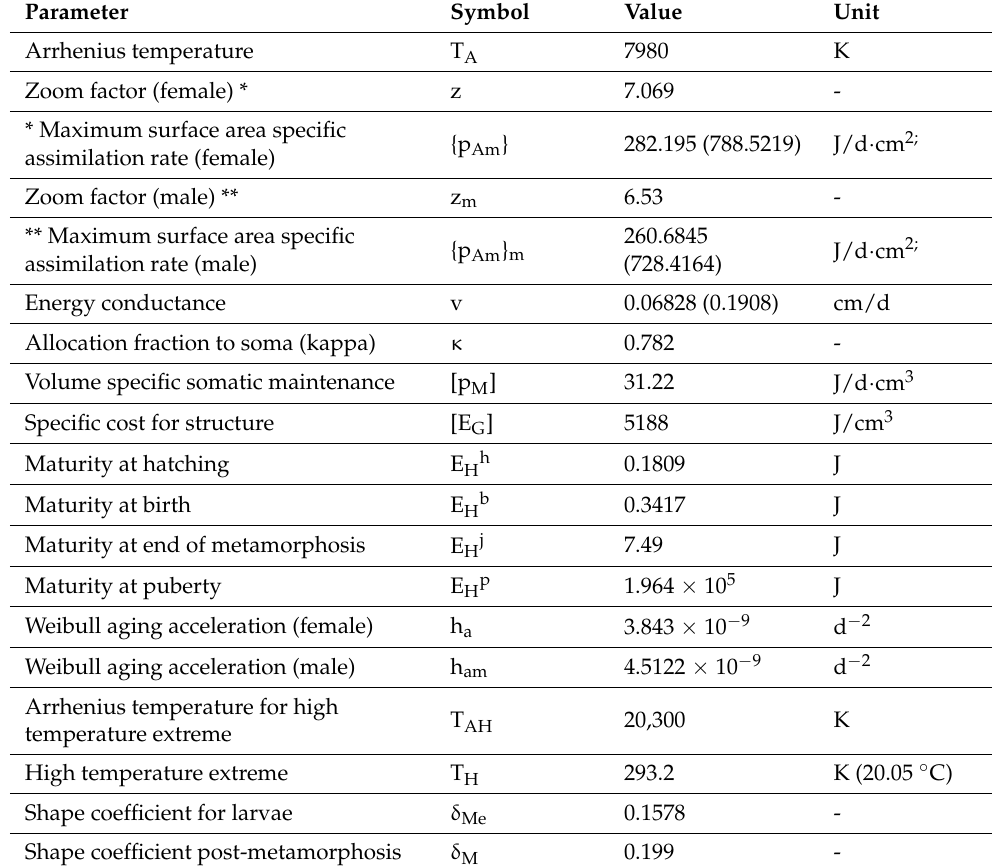
Standard parameter values from Kooijman (2010) [20]: Maximum specific searching rate, {F m } = 6.5 d − 1 · cm − 2 ; Digestion efficiency of food to reserve, . κ X = 0.8; Digestion efficiency of food to faeces, κ P = 0.1; Reproduction Specific density of structure and reserve, d V = d E = 0.2 g/cm 3